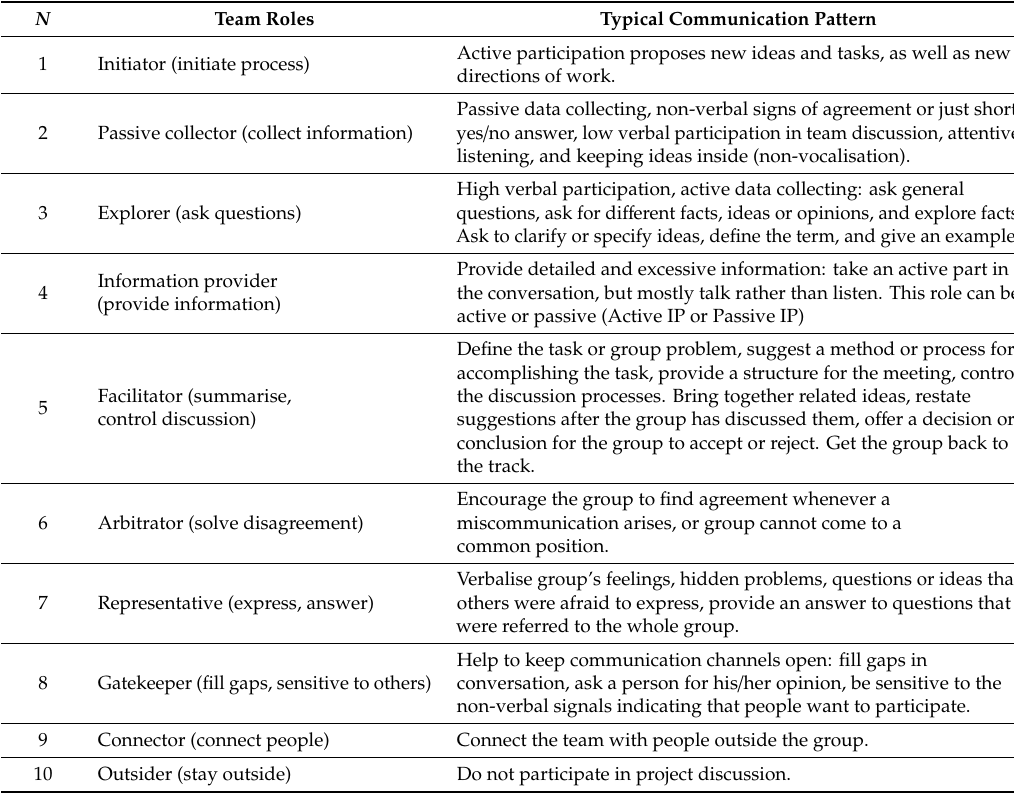
Table 1. Team roles per Nestsiarovich and Pons. Reproduced from [51] with